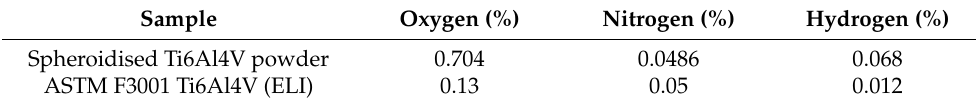
Table 6. Chemical content determined by the LECO ONH836 inert gas fusion